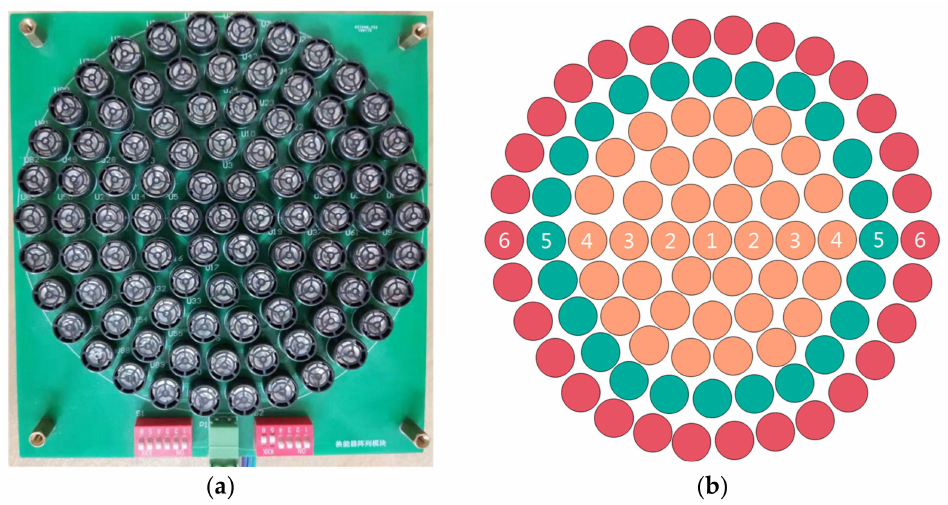
Figure 5. Adjustable PAL: ( a ) physical diagram; ( b ) schematic diagram.